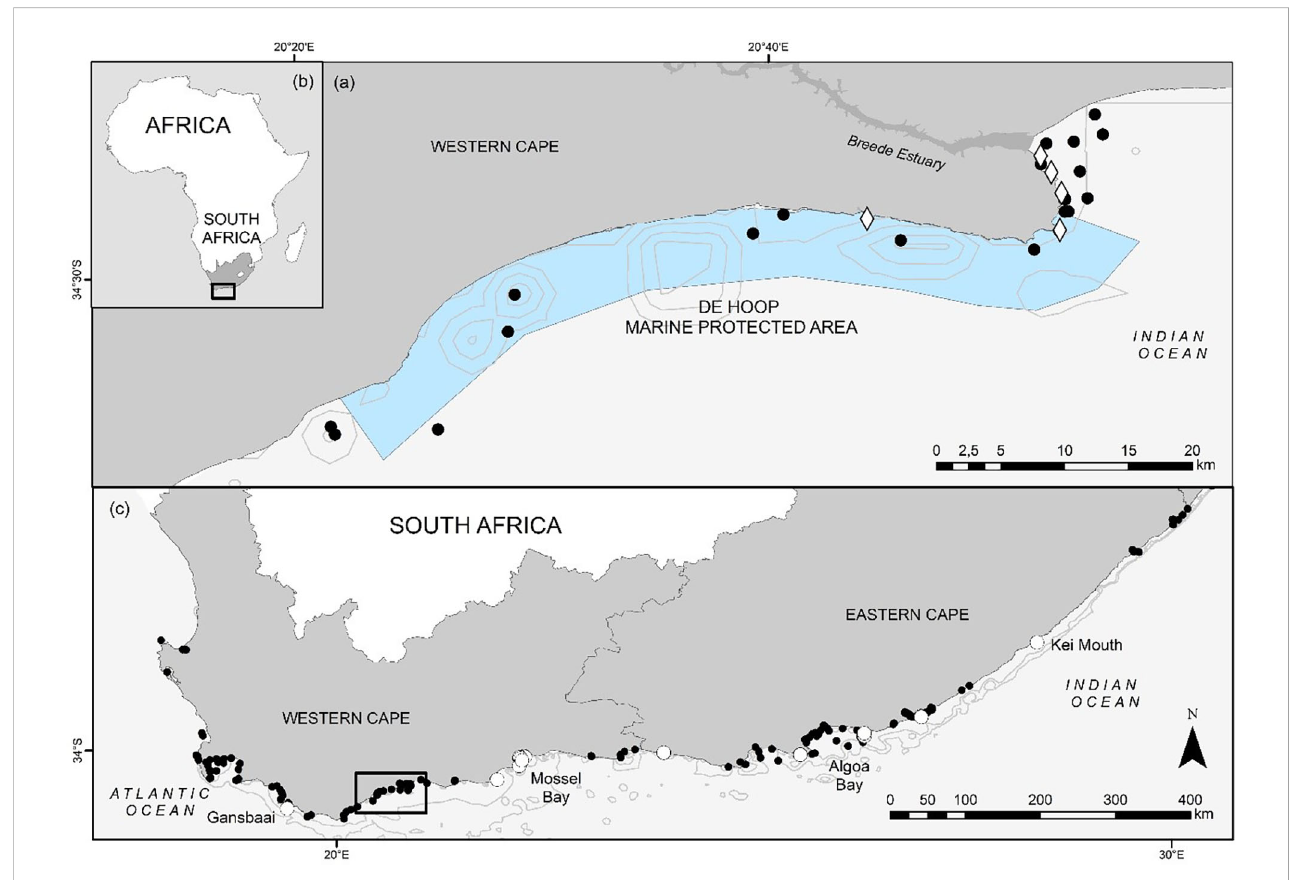
FIGURE 1 The De Hoop Marine Protected Area (MPA) boundaries and geographical placement within South Africa (A) and the African continent (B) , with acoustic receivers used to monitor the movements of juvenile S . zygaena within and adjacent to the MPA depicted by black circles. Tagging locations are depicted in white diamonds (A) . Receiver stations detecting tagged smooth hammerheads in the greater South African region are depicted by white circles (C)